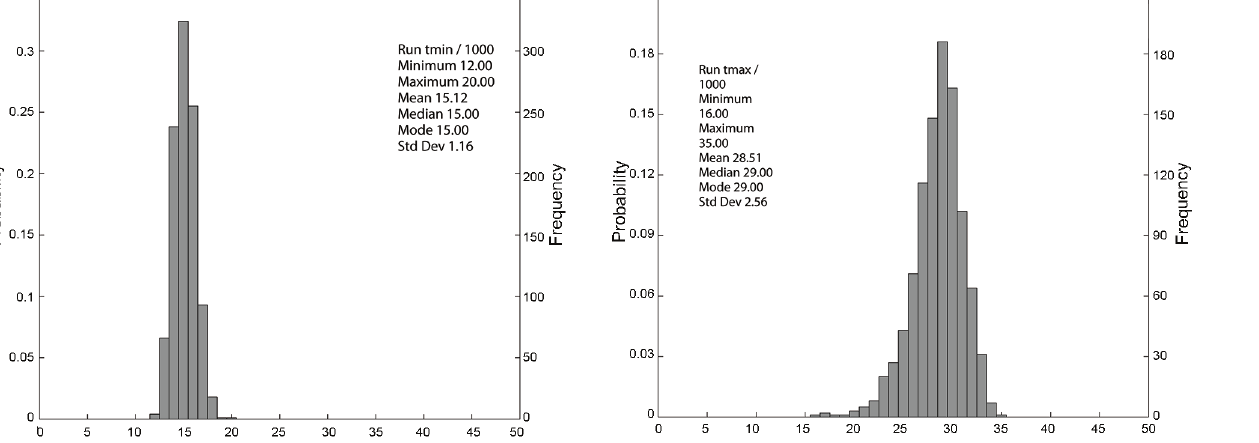
Figure 3. Probability distribution of the value of concession period (